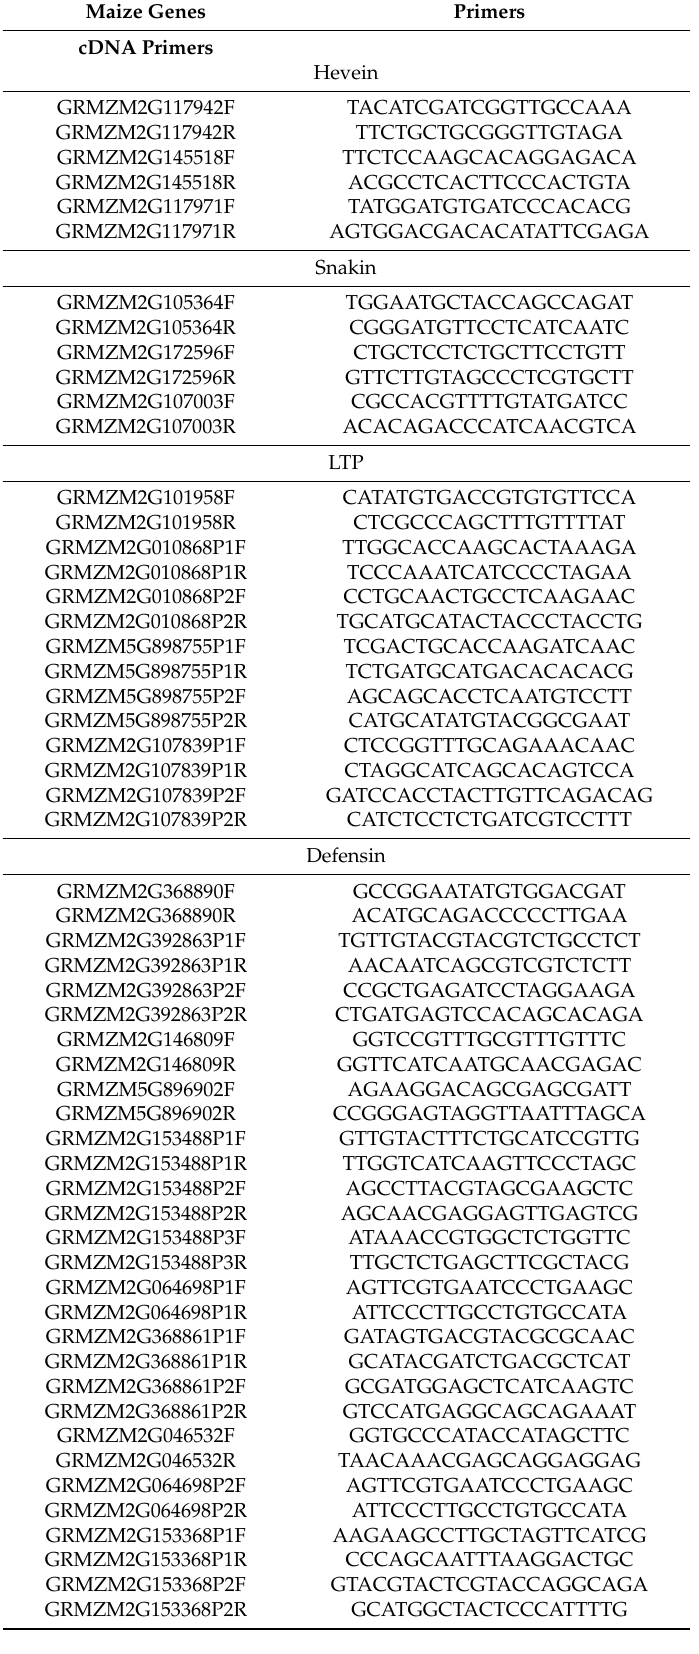
Table 2. Polymerase chain reaction (PCR) primers for cDNA and genomic DNA of maize AMP